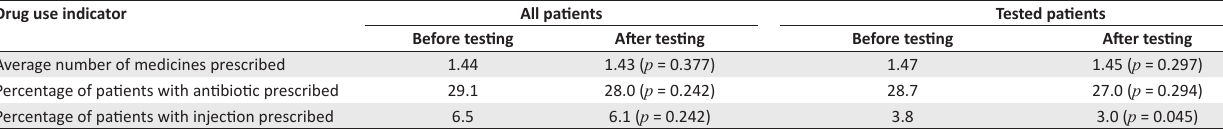
TABLE 4: Change in drug use indicators after laboratory testing. Drug use indicator All patients Tested patients Before testing